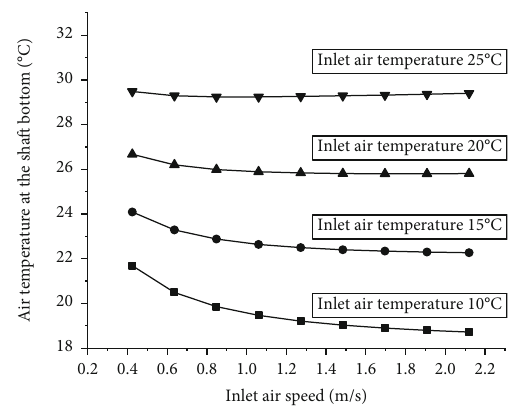
0.2 0.4 0.6 0.8 1.0 1.2 1.4 1.6 1.8 2.0 Figure 10: E ff ect of inlet air speed on the air temperature at the shaft bottom.